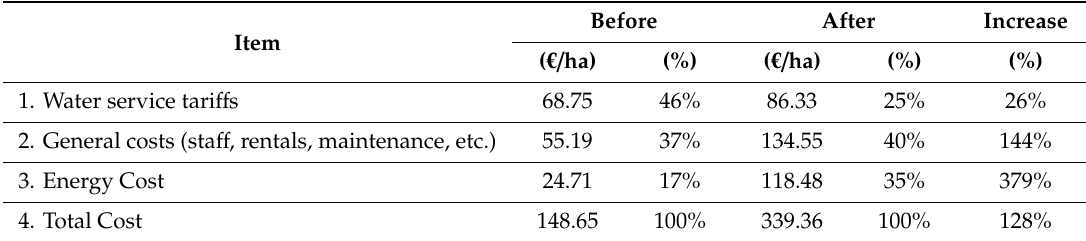
Table 1. Irrigation costs before and after a change of irrigation technology.